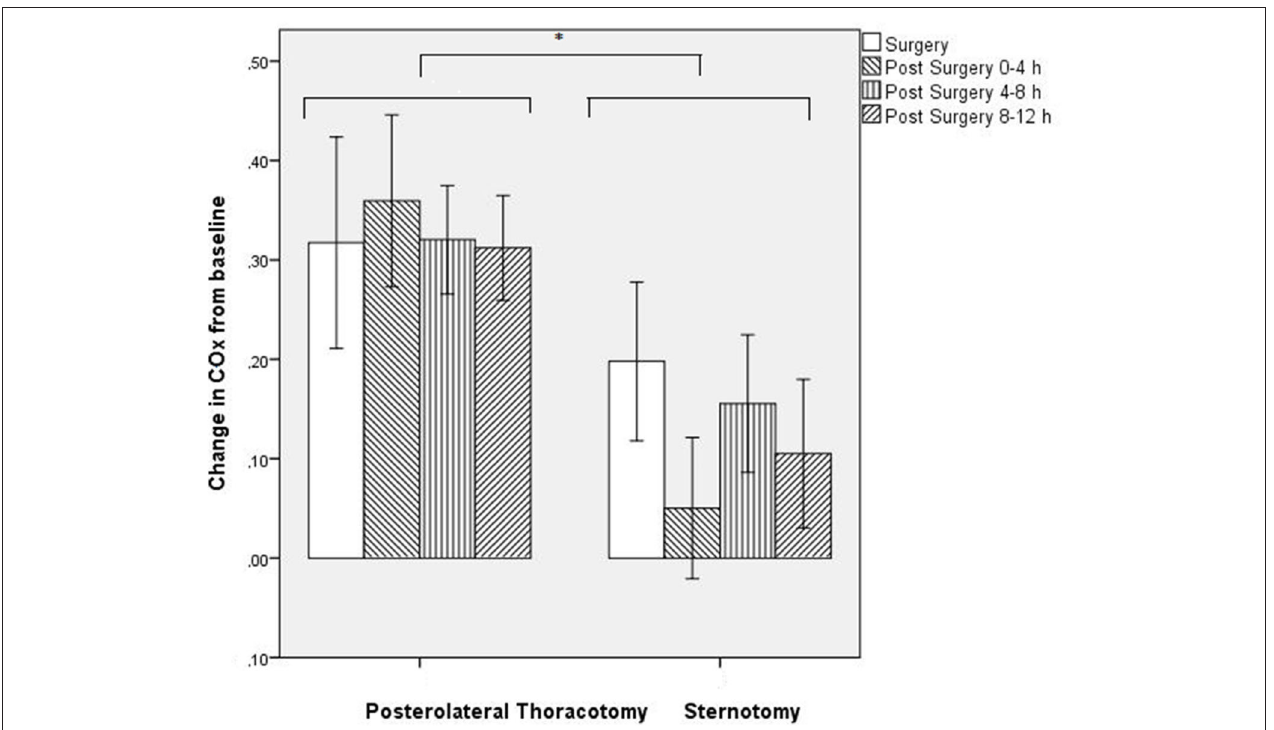
FIGURE 2 | Change in COx value ( ρ ) from baseline for both groups separately. Mean ± S.E.M. * p <